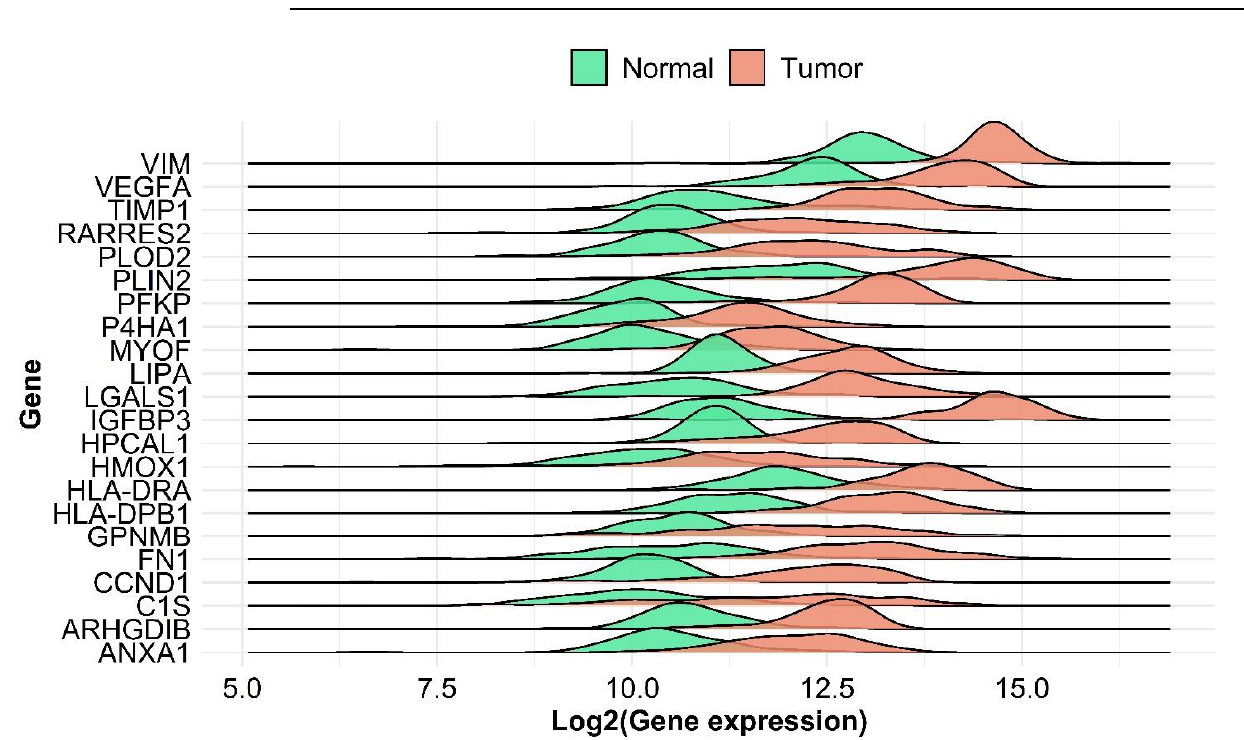
Figure 2. Differential gene expression of compared normal and ccRCC tumor samples from transcriptomic data. Ridge plots of differentially expressed genes shows the distribution of log2 expression values.